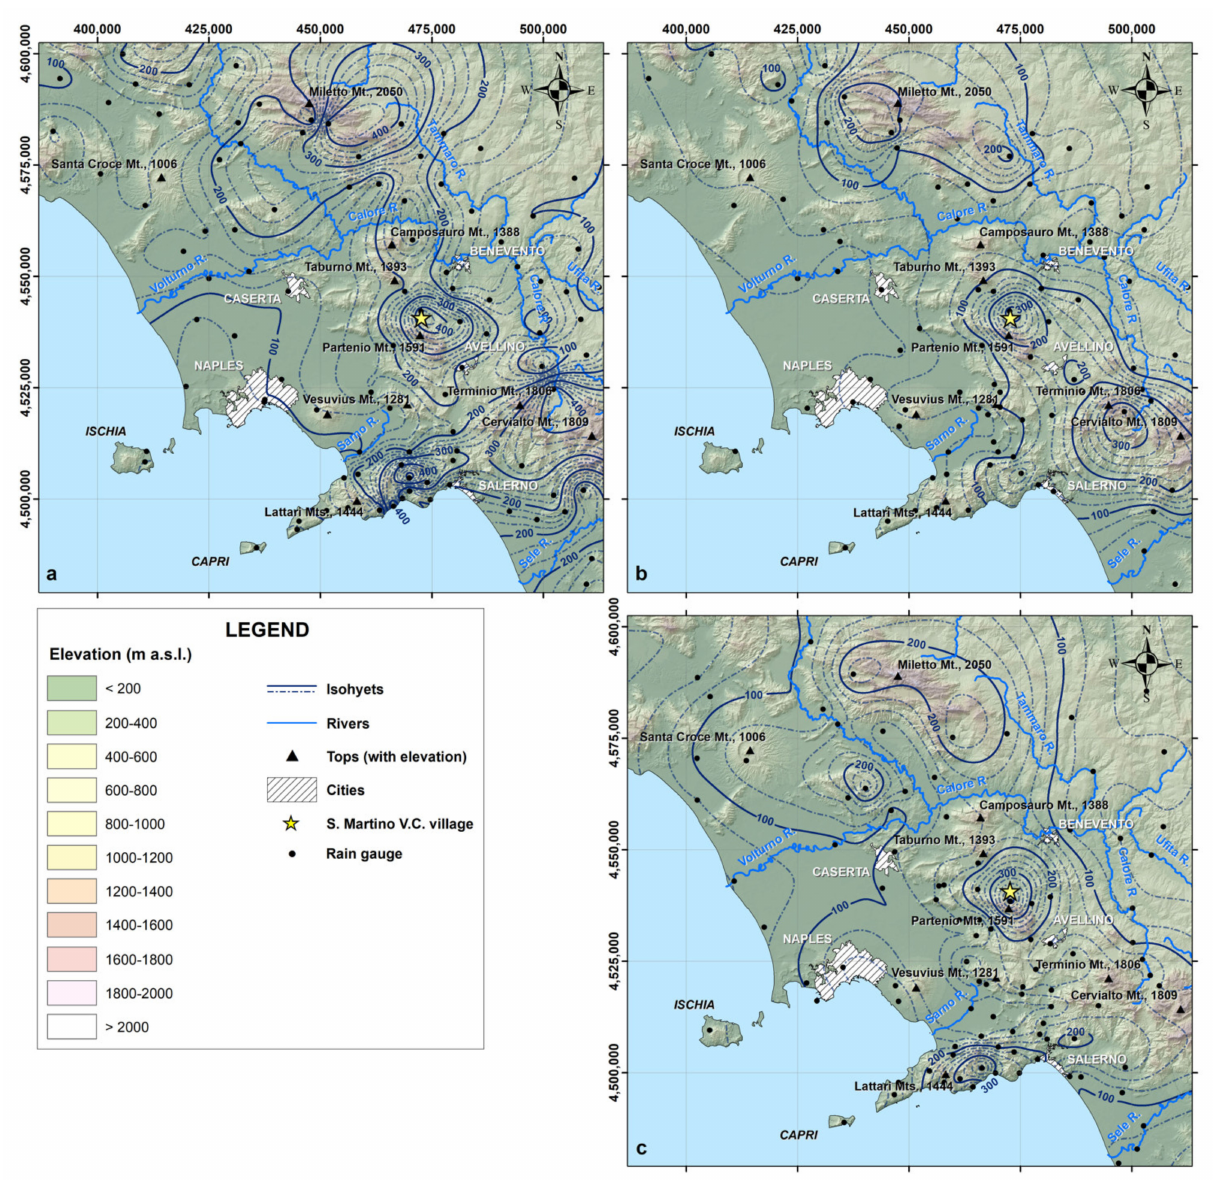
Figure 8. Rainstorm maps reconstructed by the kriging interpolation method (some rain gauges fall outside the